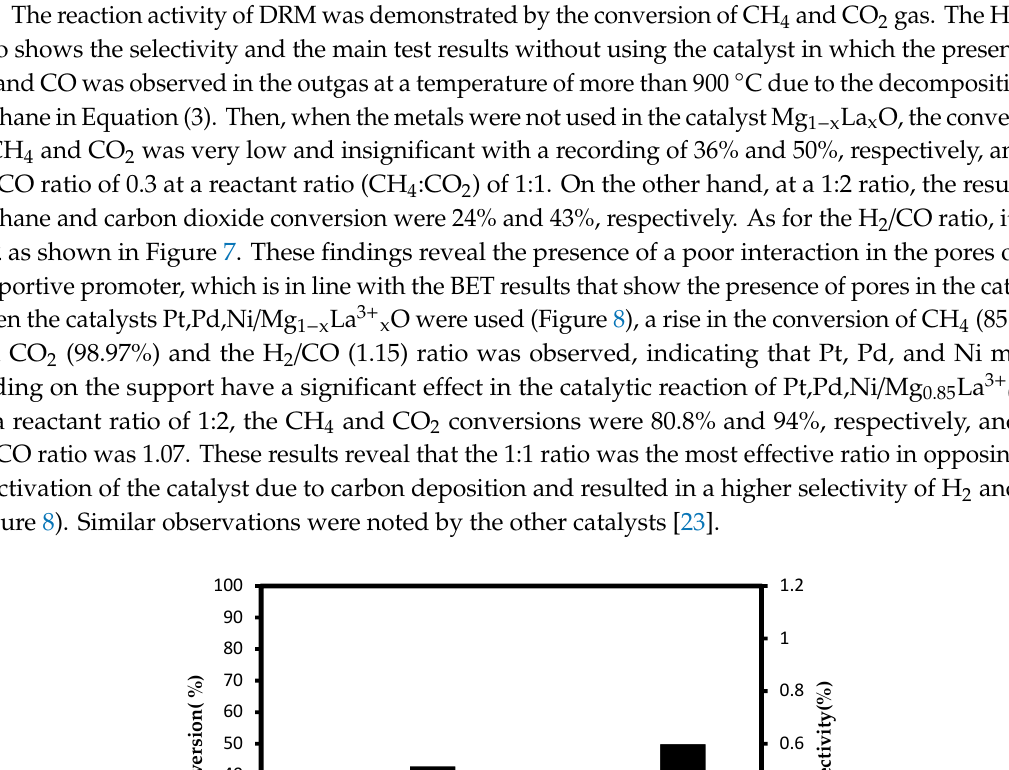
Figure 8. The effect of changing the ratio concentration of the CH 4 :CO 2 reactant a—(2:1) and b—(1:1) over the percentage of their conversion and H 2 /CO ratio for Pt,Pd,Ni/Mg 0.85 La 3+ 0.15 O catalyst at 900 °C. 2.2.2. Effects of Concentration of the Catalyst on Conversion Figure 9 and Table 4 show the effect of using different catalyst concentrations through the conversion process. The reaction conditions were set at 900 °C and 1 atm with a 1:1 reactant ratio (CH 4 :CO 2 ). The conversion of CH 4 , CO 2 , and the H 2 /CO ratio reveal that the catalysts were coordinated in the following arrangement: Pt,Pd,Ni/MgO < Pt,Pd,Ni/Mg 0.97 La 3+0.03 O < Pt,Pd,Ni/Mg 0.93 La 3+0.07 O < Pt,Pd,Ni/Mg 0.85 La 3+0.15 O. The highest reading of methane conversion was recorded for the Pt,Pd,Ni/Mg 0.85 La 3+0.15 O catalyst (85%), whereas the lowest reading was recorded for the Pt,Pd,Ni/MgO catalyst (72.83%). The recorded CH 4 conversion was less stable than the CO 2 conversion. For the CO 2 conversion process, the catalyst Pt,Pd,Ni/Mg 0.85 La 3+0.15 O demonstrated a higher conversion rate (98.97%) when compared to the catalyst Pt,Pd,Ni/MgO, which demonstrated a CO 2 conversion rate of 81.14% . The findings made it clear that the most effective conversion process was observed by the catalyst